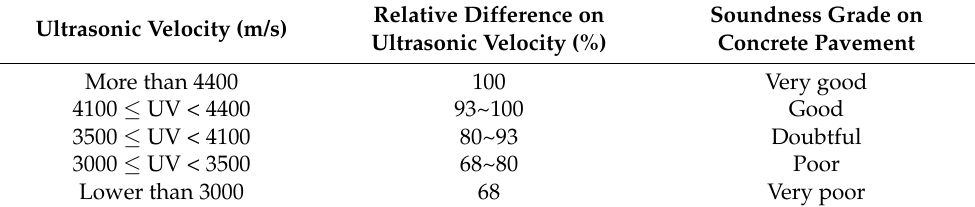
Figure 12. Estimation depth of concrete pavement deterioration. Table 4 classifies the soundness class and rating value of concrete pavement based on all ultrasonic velocity surveys obtained through this study. Table 4. Soundness rating based on ultrasonic velocity of concrete